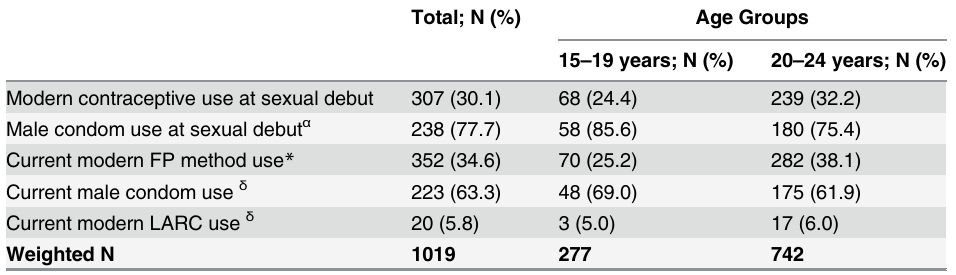
α Among those who used a contraceptive method at sexual debut, weighted n = 307 δ Among those currently using a modern method, weighted n = 352 * Distributional differences between the age groups are statistically signi fi cant at p-value <